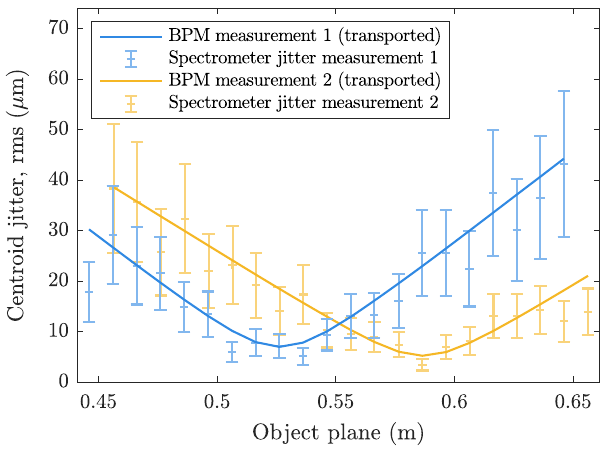
FIG. 6. Comparison of the centroid jitter measured on the spectrometer screen and with the two-BPM method (artificially transported through the quadrupoles to the spectrometer loca- tion). Error bars represent the standard error of the mean. A statistically significant agreement is observed, verifying the accuracy of both measurement